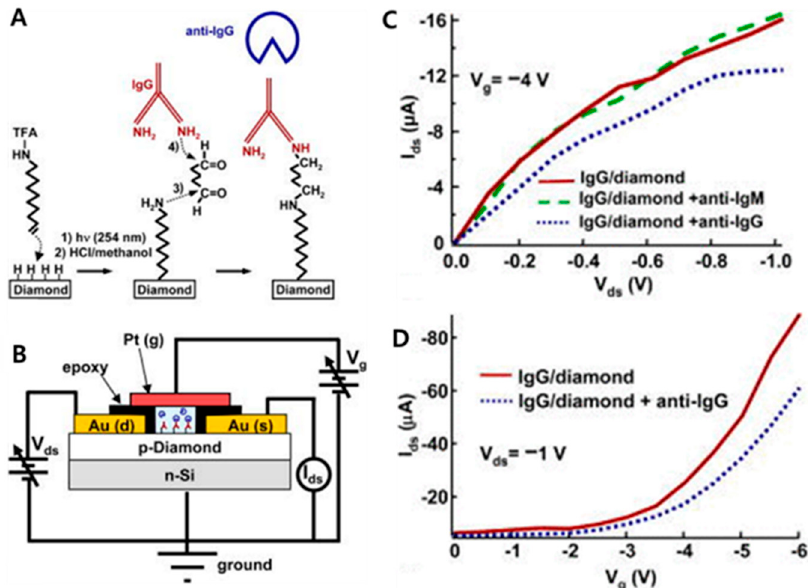
Figure 8. ( A ) Schematic illustration for procedures of linking human IgG to diamond surfaces. ( B ) Schematic illustration of a diamond-based bio-FET structure. ( C ) Ids–Vds curves at Vg = − 4 V for an IgG-modified diamond FET before (solid line) and after exposure to anti-IgM (dashed line) and to anti-IgG (dotted line). ( D ) Ids–Vg curves at Vds = − 1 V for IgG-modified diamond FET before (solid line) and after exposure to anti-IgG (dotted line). Reproduced with permission from Ref. [53]